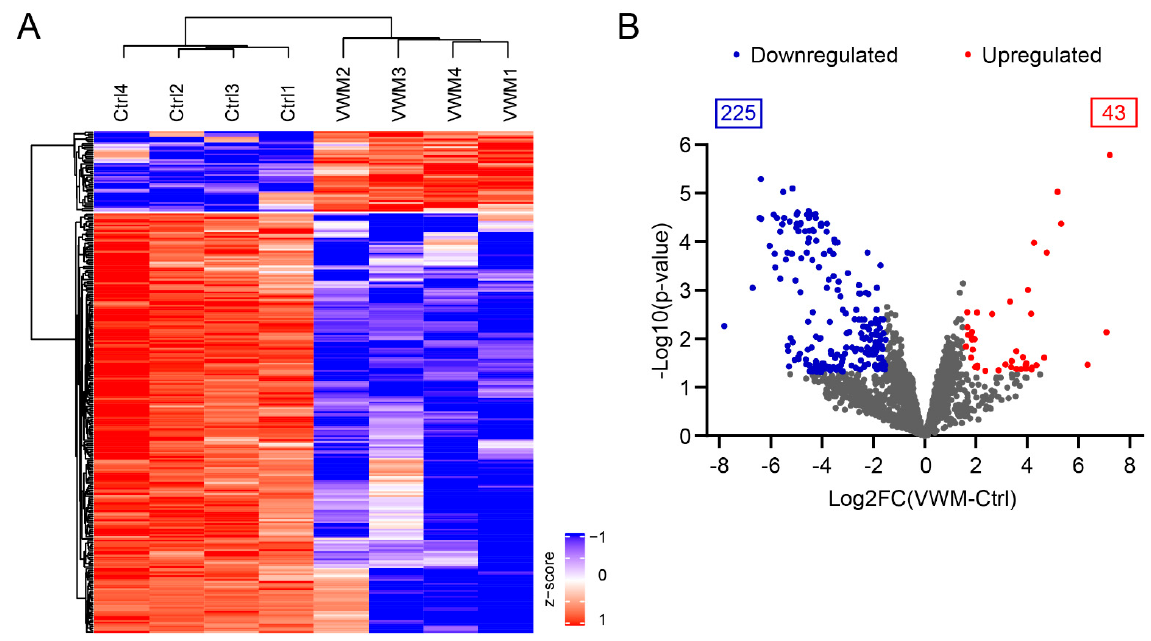
Figure 1. VWM cortex shows substantial differences from control cortex at the protein level . ( A ) Heat map of z-scored abundances (LFQ intensities) of the 268 significantly differentially expressed proteins in VWM cortex compared to control cortex. Hierarchical clustering revealed two separate expression clusters. ( B ) Differential protein expression in control versus VWM cortex. Volcano plot displaying significant differentially expressed proteins with at least ±1.5-fold change. Proteins downregulated and upregulated in VWM are colored in blue and red, respectively (adj. p -value < 0.05). Not significantly differentially expressed proteins (adj. p -value > 0.05) and proteins with fold changes between ±1.5 are colored in gray.